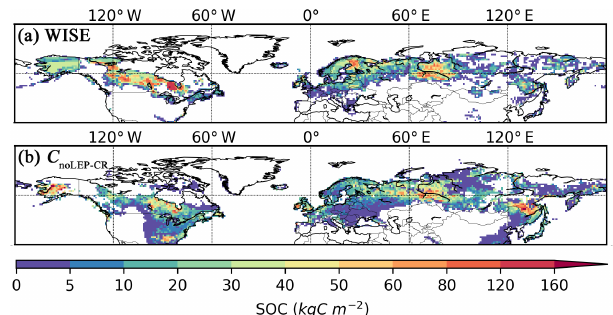
Figure 8. Observed and simulated peatland soil carbon den- sity. (a) Peatland (Histosols) soil carbon density from the WISE soil database and (b) simulated peatland soil carbon density ( C noLEP-CR ); pattern and timing of deglaciation have been consid- ered. Areas dominated by Leptosols have been masked and areas occupied by crops have been excluded, under the assumption that cropland occupied peatland in proportion to grid cell peat fraction.